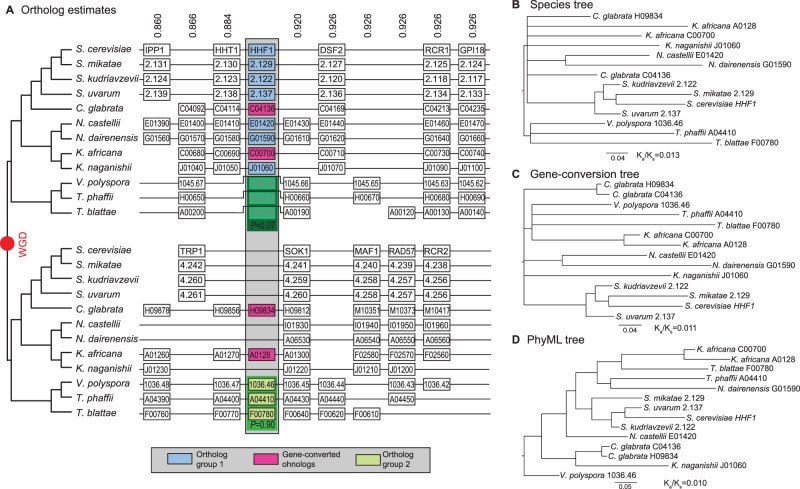
(A) Orthology prediction for 12 post-WGD yeasts from POInT for the genomic region around histone 4 (HHF1). WGD produced two duplicated regions, shown as the top and bottom panels. For this set of genes (gray column) there are two orthology assignments of reasonably high probability: One that makes the genes from Vanderwaltozyma polyspora, Tetrapisispora phaffii, and Tetrapisispora blattae paralogous to the nine genes in the upper panel (P = 0.90) and one that makes them orthologous (P = 0.07). Importantly, neither of these relationships contradicts the inference that gene H09834 from Candida glabrata and gene A0128 from Kazachstania africana are paralogous to the upper group of nine genes (hence P > 0.97 for that assignment). As a result, we expect the gene tree of these 11 sequences to have these 2 genes cluster outside of the other 9, as depicted in the species tree of B. Instead, the two genes in pink from C. glabrata and K. africana are each other’s closest relatives in the tree, a result only explicable under the hypothesis of gene conversion. (B) Fit of the HHF1 sequence alignment to the species tree from A under the MG/GY 94 model. (C) Fit of the HHF1 sequence alignment to a hypothesized gene conversion tree under the MG/GY 94 model. (D) Maximum-likelihood estimate of the gene tree from PhyML (see Methods) for HHF1 fit to the MG/GY 94 model.